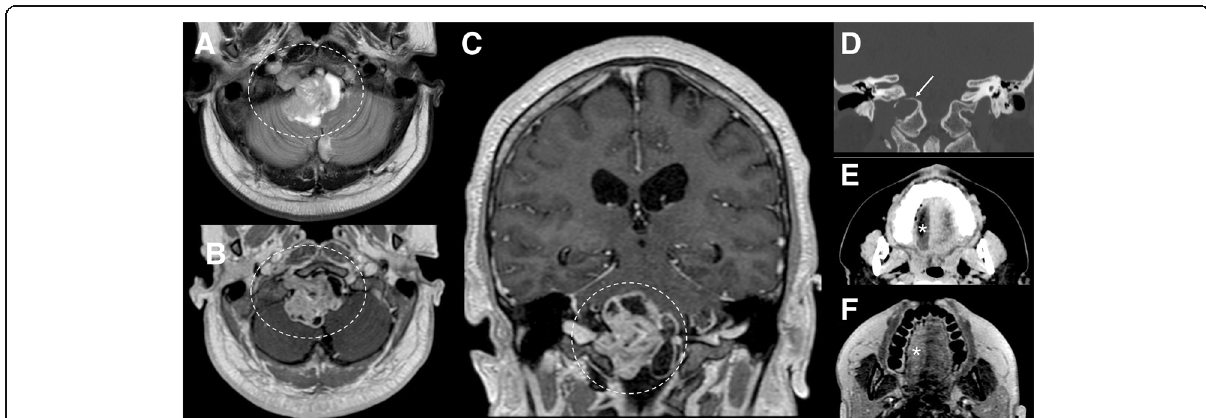
Fig. 14 Hypoglossal schwannoma. MRI T2-weighted axial image ( a ), T1-weighted post-gadolinium axial ( b ), and coronal images ( c ) demonstrate an extra-axial expansive lesion (dotted circles), mildly hyperintense with heterogenous contrast enhancement, surrounded by cystic components. The mass is located along the course of the right hypoglossal nerve. CT (bone window, d ) clearly shows the enlargement of the right hypoglossal canal (arrow). Atrophy of the right tongue muscles (asterisks) is well visible at CT ( e ) and T1-weighted axial sequence ( f ) as hypodense and hyperintense area, respectively